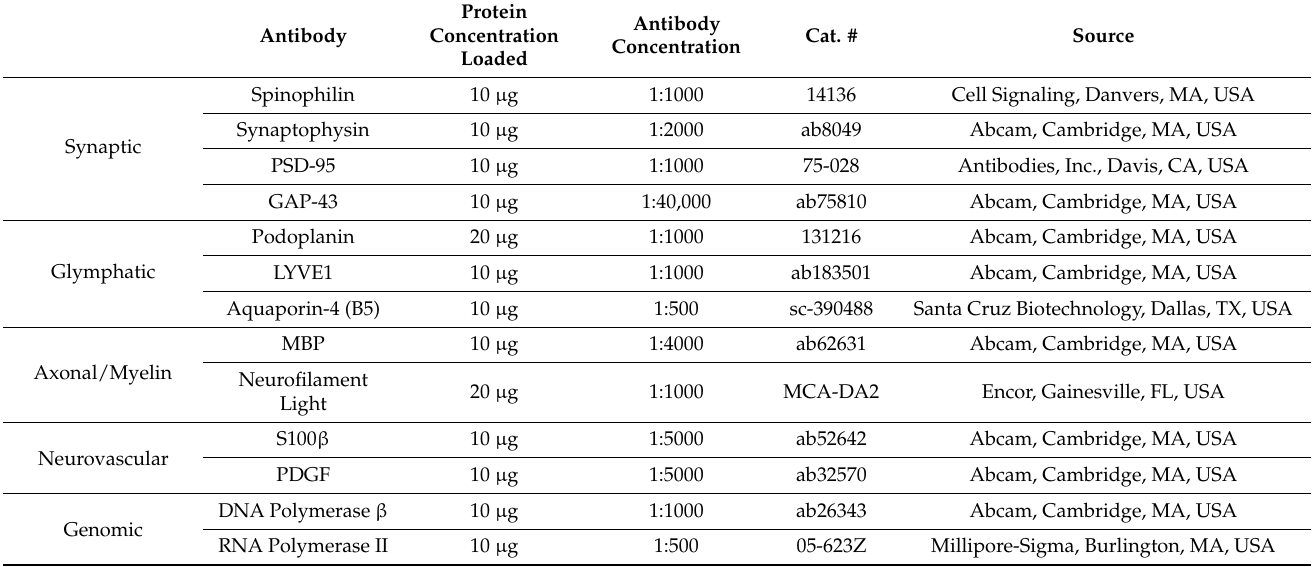
Table 1. Antibodies and related information for Western Blots (WB).